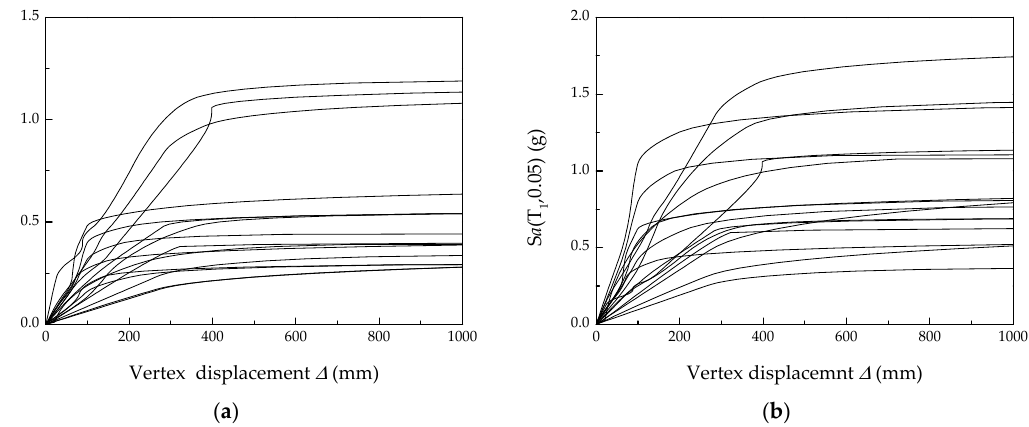
Figure 11. IDA curve cluster of frames with RC short columns. ( a ) PGA- ∆ IDA curves; ( b ) S a ( T 1 , 5%)- ∆ IDA curves.